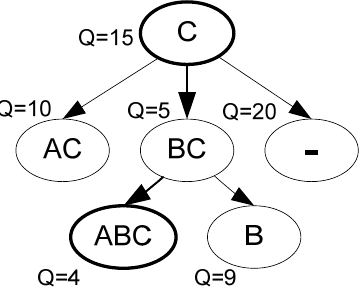
Figure 5. Search of the optimal configuration. S=(C) is the initial configuration with quality criterion Q =15 and S=(ABC) is the goal state with Q =4. Bold circles stand for current (C) and future (ABC)